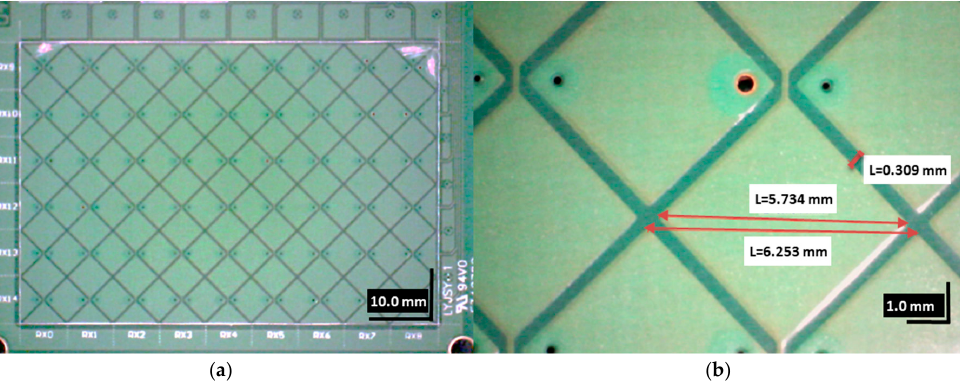
Figure A3. ( a ) One layer PCB 9 × 6 sensor matrix; and ( b ) gap and pitch size.